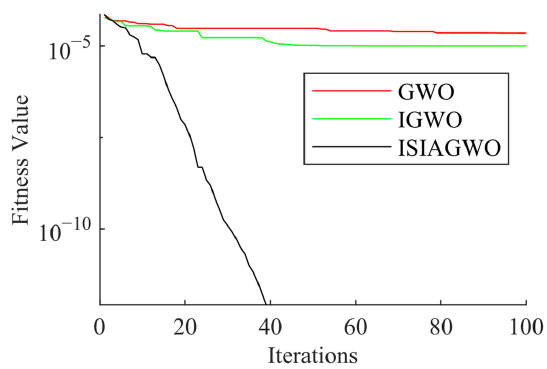
Figure 5. Generalized Rastrigin’s Function Optimization Curves.